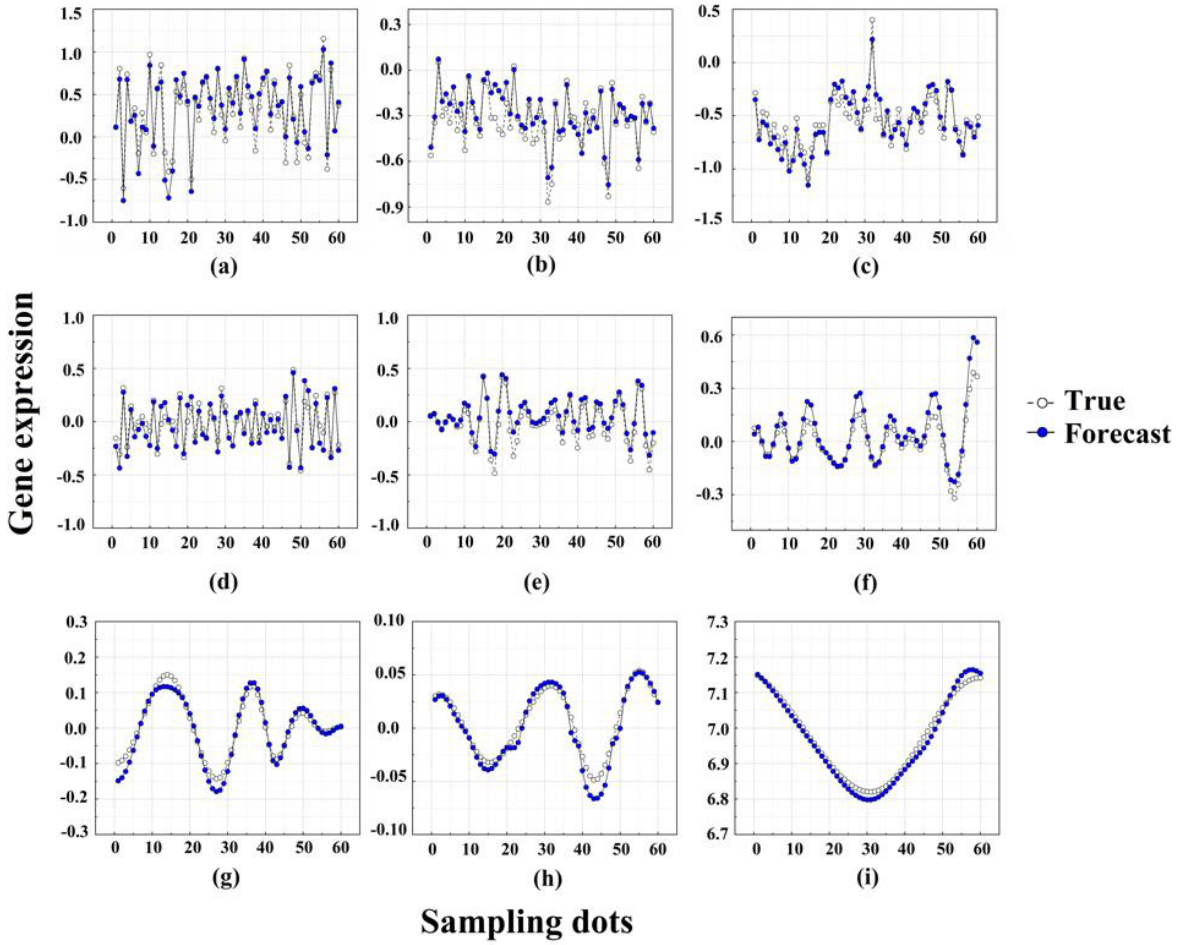
Figure 3. The prediction results of each component using LSTM. ( a – i ) correspond to the results of components IMF 1 -IMF 9 , respectively. The expression values of a total of 60 degradation-related genes were decomposed into 9 IMFs by EMD, and the prediction of gene expression was performed according to these 9 modules separately. Specifically, the white dots represent the true values and the blue dots represent the predicted values. From ( a – i ), it can be seen that the nonsmooth signal is becoming smoother, and the line of blue dots (predicted values) is also approaching the line of white dots (true values).